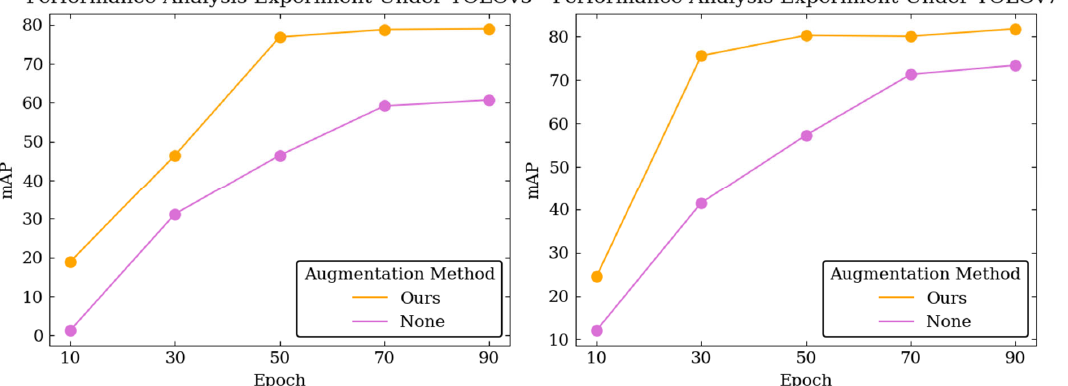
the model that used VGCopy ‐ paste during training, and “None” denotes the model that did not model that used VGCopy-paste during training, and “None” denotes the model that did not use any use any data augmentation method during training. data augmentation method during training.